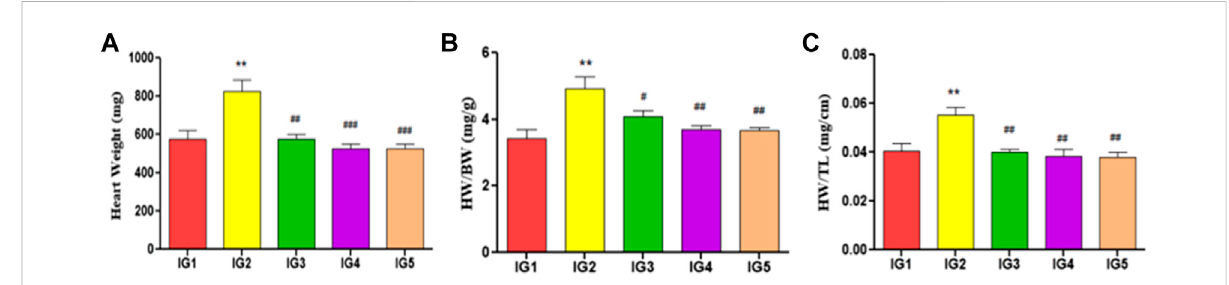
FIGURE 4 Effect of ISO and GC pre-treatment on cardiac hypertrophy parameters- (A) Heart weight (mg), (B) Heart weight index (mg/g) and (C) Heart tail index (g/cm). Results are expressed as mean ± SD for groups of three observations. Statistically signi fi cant at *** p < 0.001, ** p < 0.01, * p < 0.05 as compared to IG1 and ### p < 0.001, ## p < 0.01, # p < 0.05 when compared to IG2 as calculated by one-way ANOVA followed by Dunnet ’ s multiple comparison